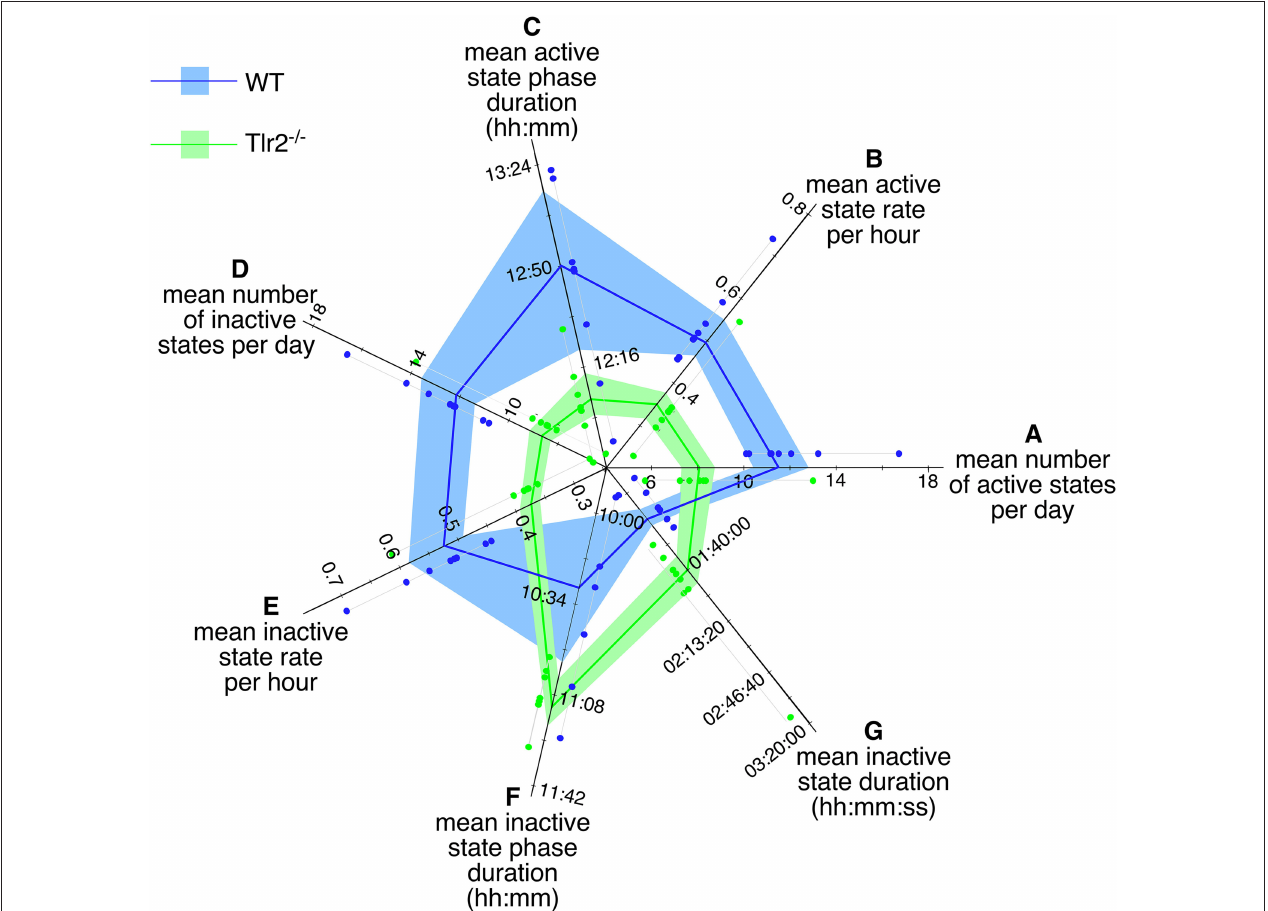
FIGURE 2 | 4–4.5 months old Tlr2 − / − mice have fewer, more consolidated active and inactive states throughout the day. Polygon plot of significant daily active and inactive state properties. Light blue region spans the first through third data quartiles for all WT mice; the dark blue line depicts property median values for WT. Similarly, light green region spans the first through third data quartiles for all Tlr2 − / − mice; the dark green line depicts property median values for all Tlr2 − / − . Thin gray lines group data points for each genotype/property combination; these values are offset from their corresponding axis for clarity (A) . Number of daily active states (B) . Daily active state rate (per hour) (C) . Daily active state phase duration (D) . Daily number of inactive states (E) . Daily inactive state rate (per hour) (F) . Daily inactive state phase duration (G) . Median duration for a single inactive state. Note that axis origins do not start at